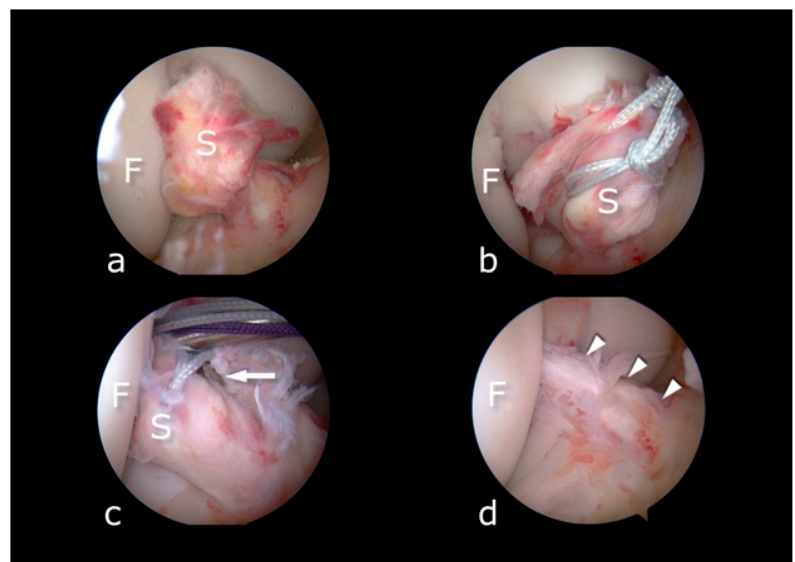
Figure 2. ( a ) Fresh ACL rupture. Stump (S) is waving in front of the intercondylar notch of the femur (F). ( b ) The stump (S) is sutured by means of the closed-loop FiberLink sutures and retracted from the femoral bone (F). ( c ) After preparation of the femoral tunnel the stump (S) is repositioned to meet native insertion on the femur (F). Next, the tibial tunnel is drilled. The drill tip is visible in the center of the stump (arrow). ( d ) After completion of the procedure, the tension of the repaired ACL (arrowheads) and FiberTape is checked and a full range of motion confirmed.